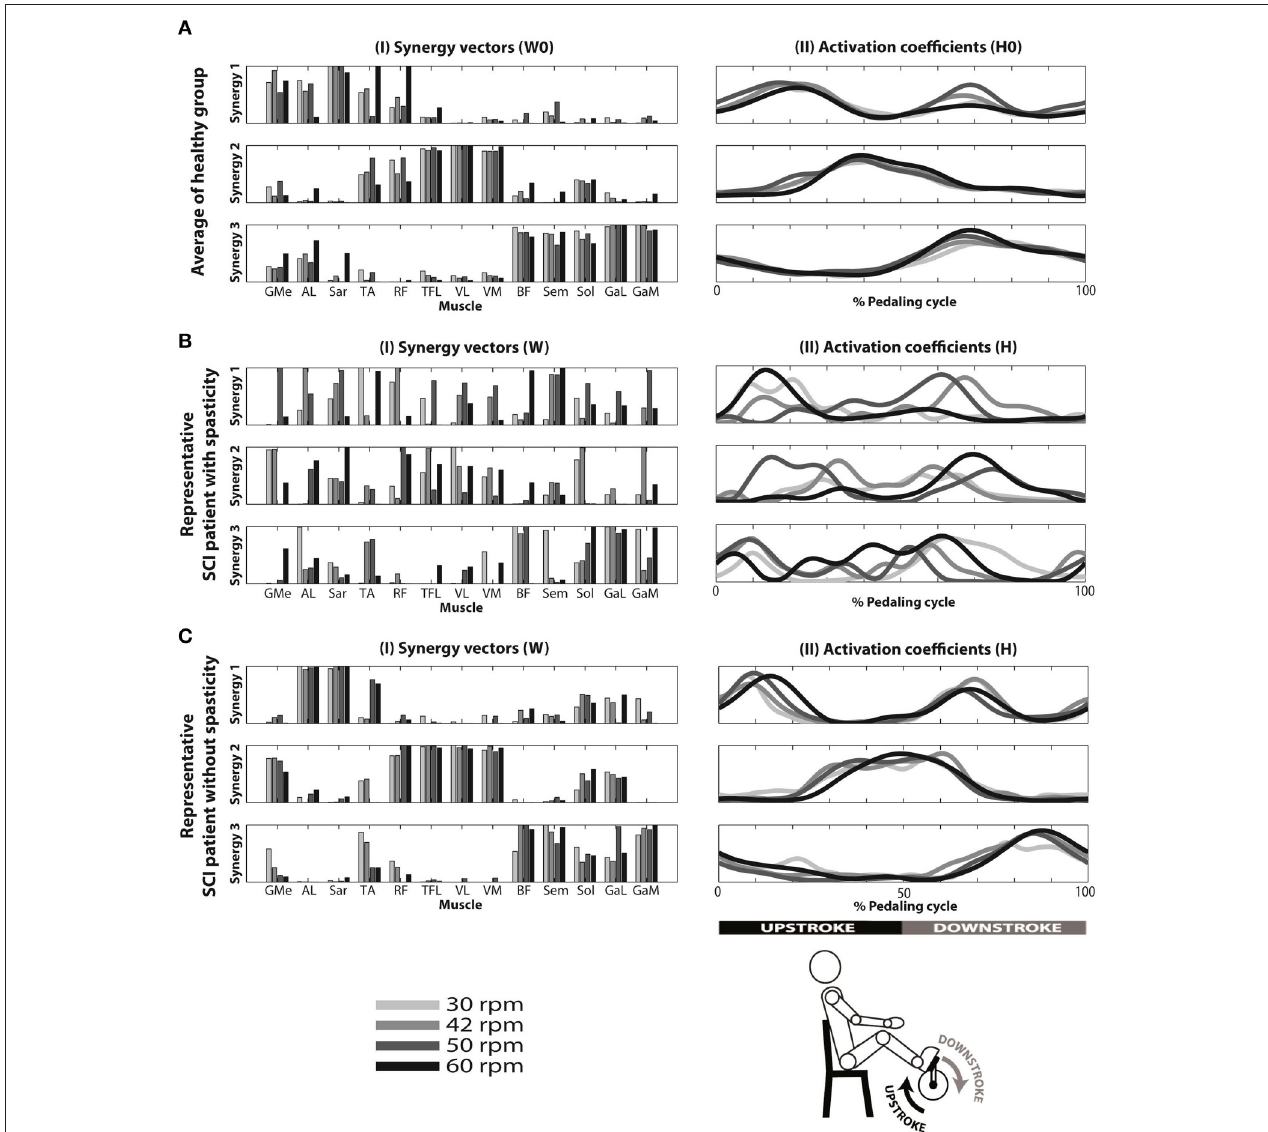
FIGURE 3 | Reconstruction of EMG envelopes in four speeds (30, 42, 50, and 60rpm) using concatenated data from the 10 healthy subjects (A), and individual data from a patient with spasticity—ID 04 (B) and a patient without spasticity—ID 09 (C), applying the NNMF algorithm with three synergies. I: muscle synergy vectors. Each muscle synergy vector has a time-invariant profile, representing the relative contribution of each synergy for each muscular pattern. Muscle synergy vectors were normalized by their maximum value. II: averaged activation coefficients, indicating time-variant profiles responsible to activate each